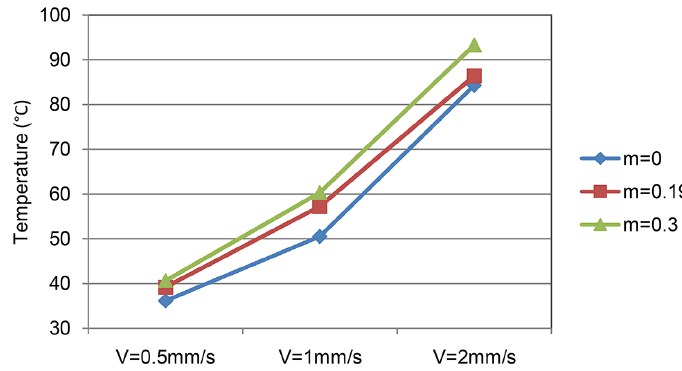
Fig.3: Maximum work‑piece temperature as a function of velocity and friction (immediately after end of the process)